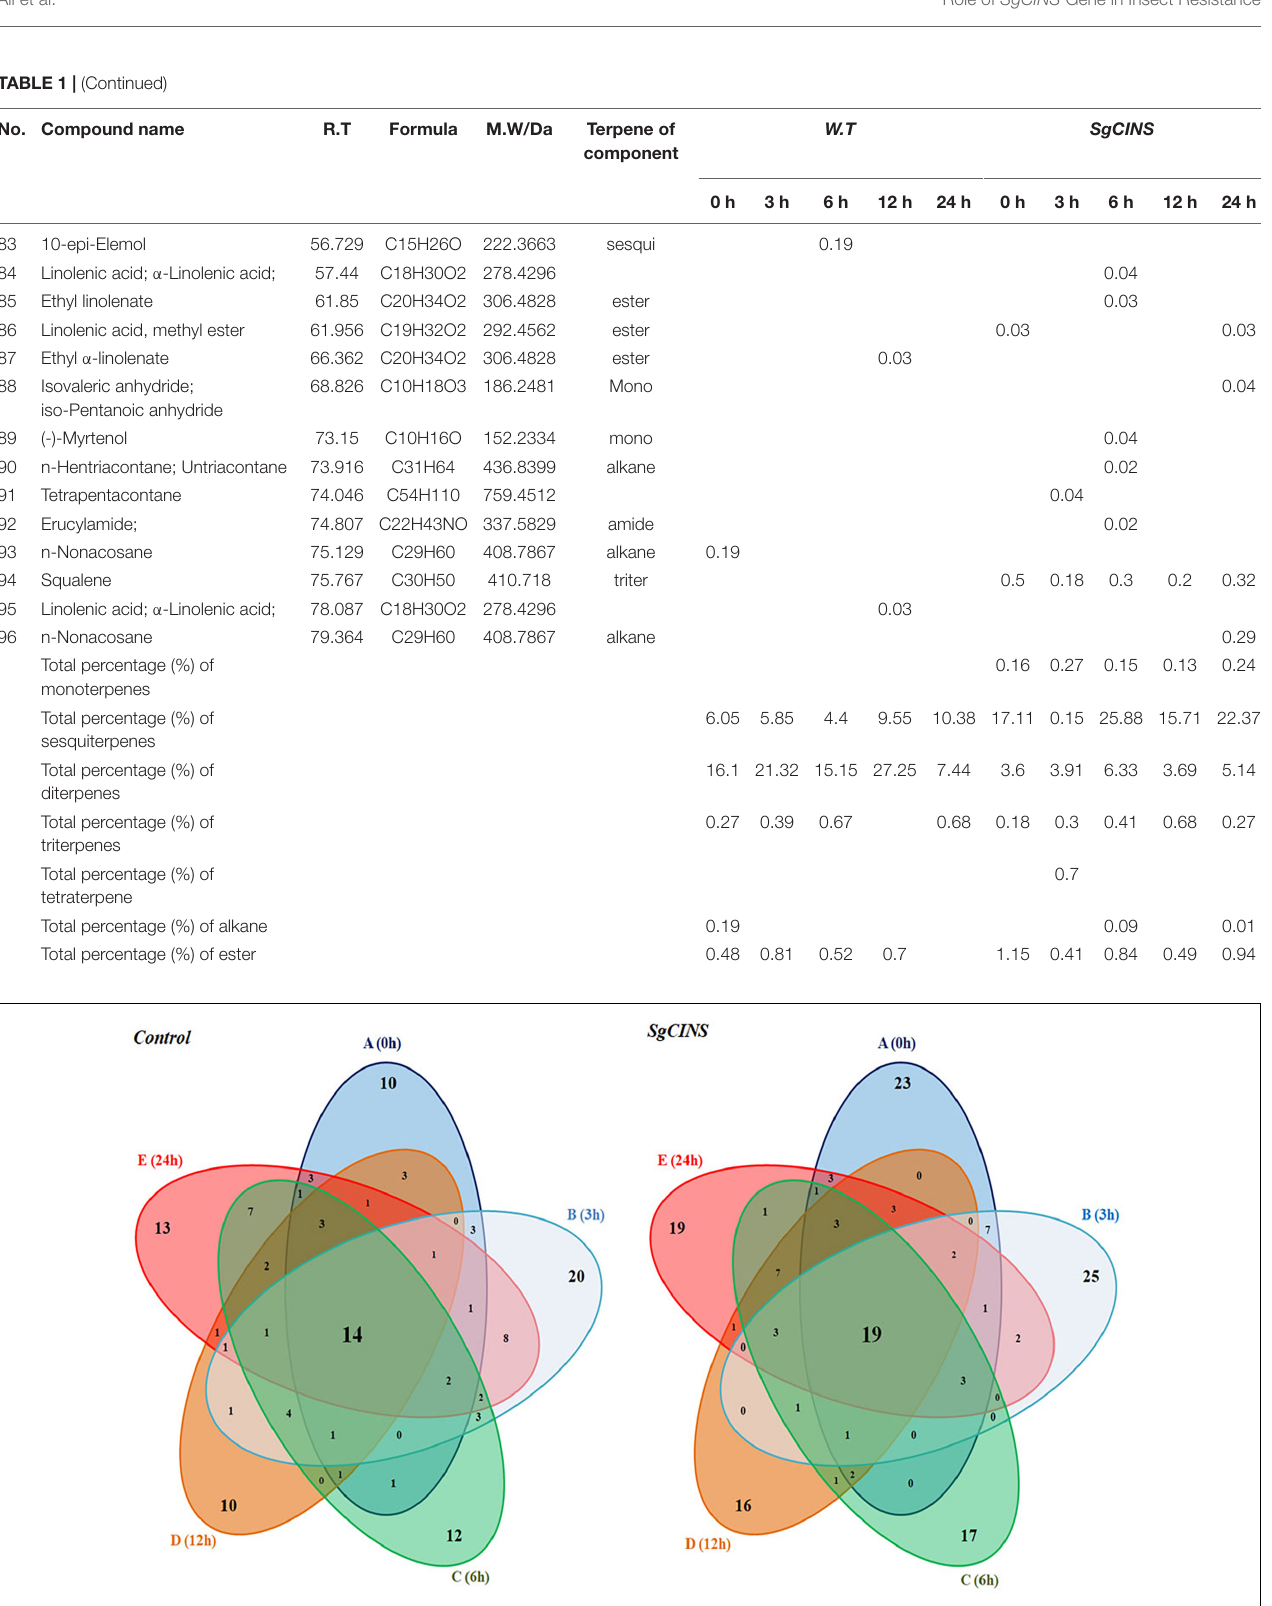
FIGURE 6 | Five-way Venn diagram to show the number of unique and common compounds in the essential oil extracts from control and transgenic tobacco plants at different times from force-feeding assays for insect resistance [e.g., 0 h (A), 3 h (B), 6 h (C), 12 h (D), and 24 h (E)].